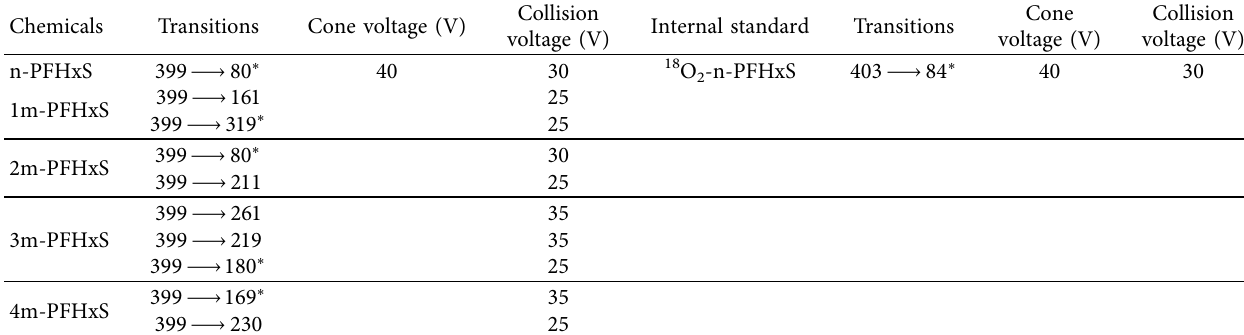
Table 3: Conditions of the MS/MS for isolation of target analytes and corresponding internal standard for quantification. Chemicals